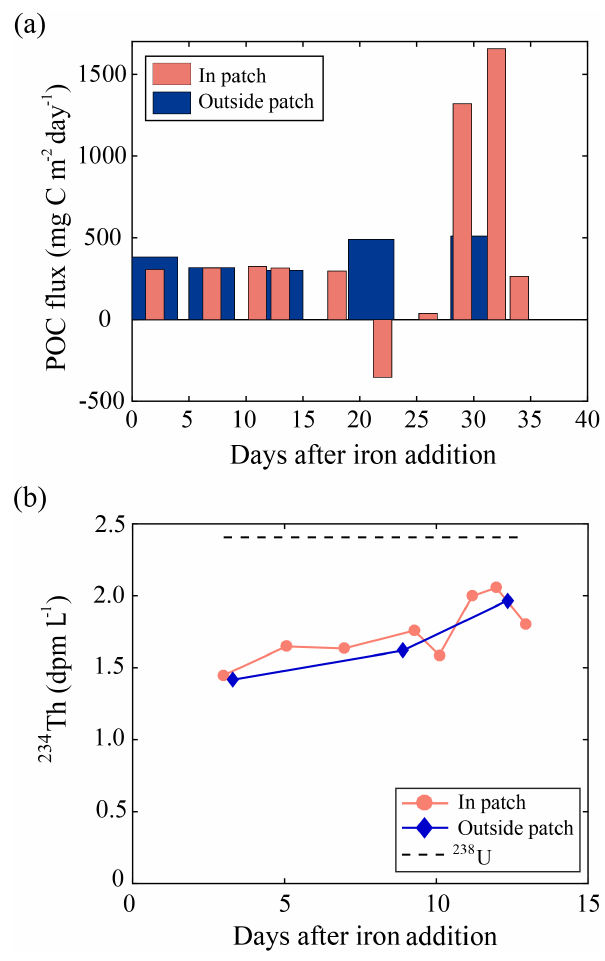
Figure 8. (a) Time series of particulate organic carbon (POC) fluxes estimated from the water-column-based 234 Th method (mgCm − 2 day − 1 ) of the upper 100m layer inside (red bar) and out- side the fertilized patch (blue bar) during the European Iron Fertil- ization Experiment (EIFEX) (modified from Smetacek et al., 2012). (b) Time series of vertically integrated 234 Th (dpmL − 1 ) inside (red circles) and outside the fertilized patch (blue diamonds) relative to the parent uranium-238 ( 238 U; dpmL − 1 ; dotted black line) during the Southern Ocean Iron Release Experiment (SOIREE) (modified from Nodder et al.,